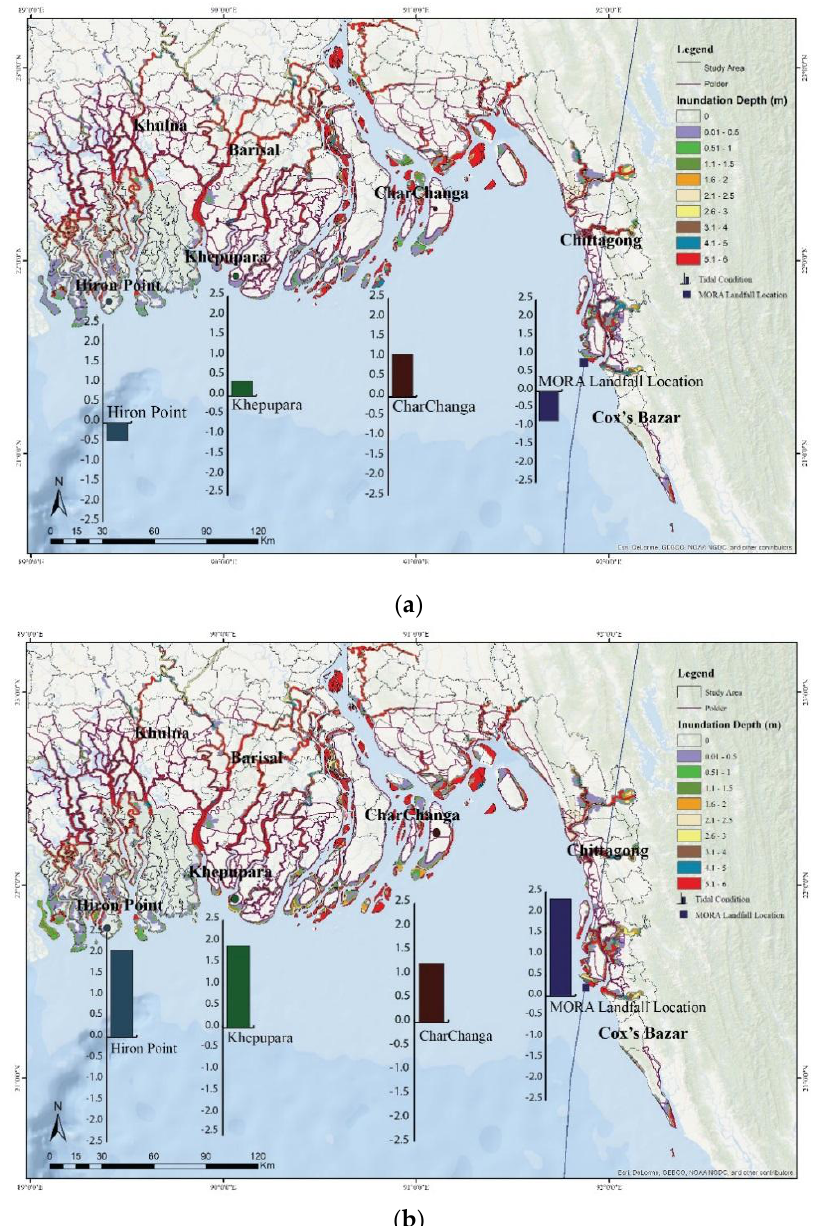
Figure 6. Comparison of tidal water level (shown by bar diagram) at the time of landfall and associated inundation extent and depth due to ( a ) TC Mora, and ( b ) the synthetic cyclone.